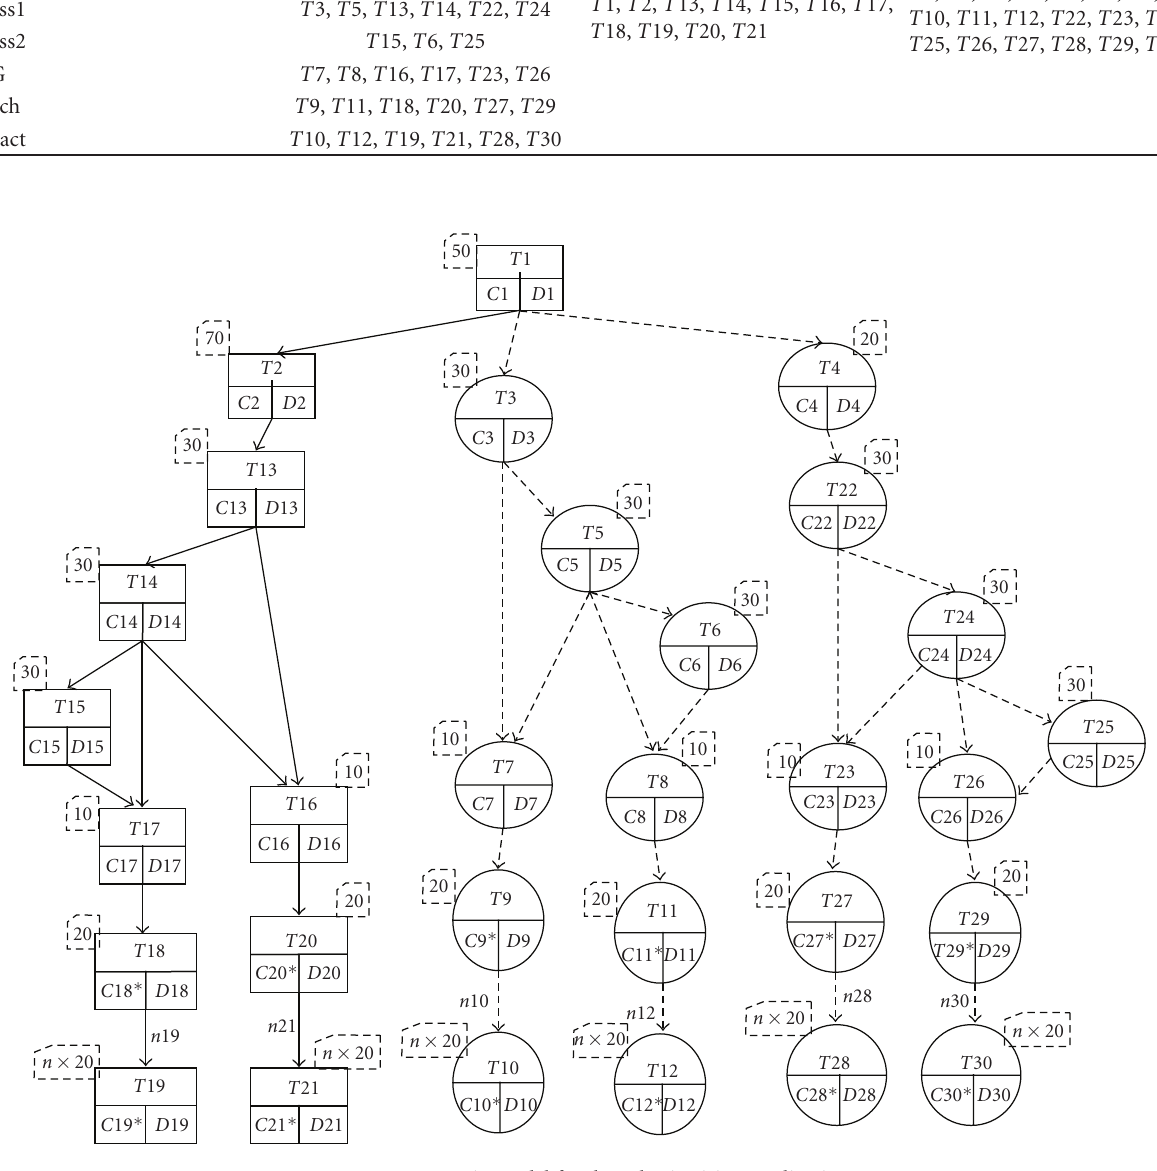
Figure 10: Dynamic model for the robotic vision